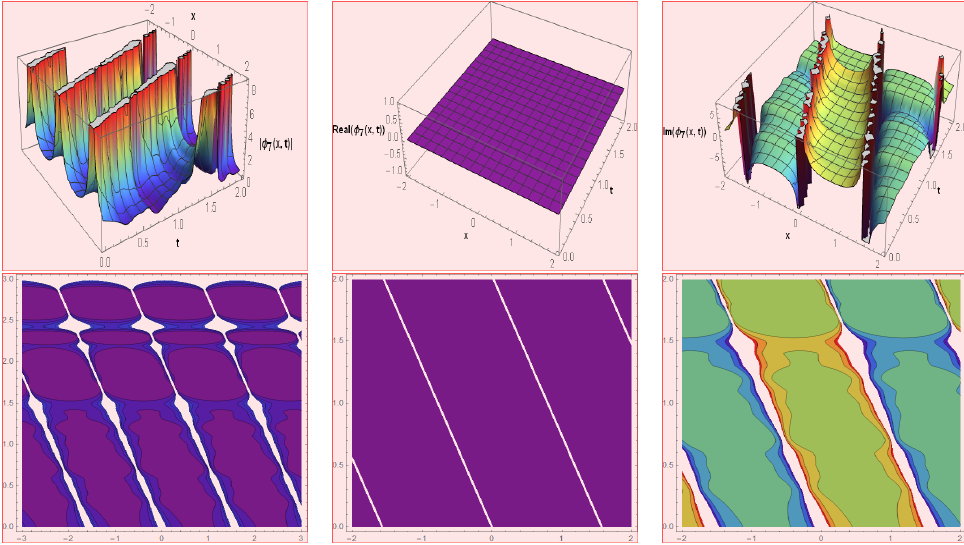
Figure 6. The absolute, real, and imaginary behavior in the shape of 3D and their corresponding contour plots are dispatched for φ 7 ( x , t )